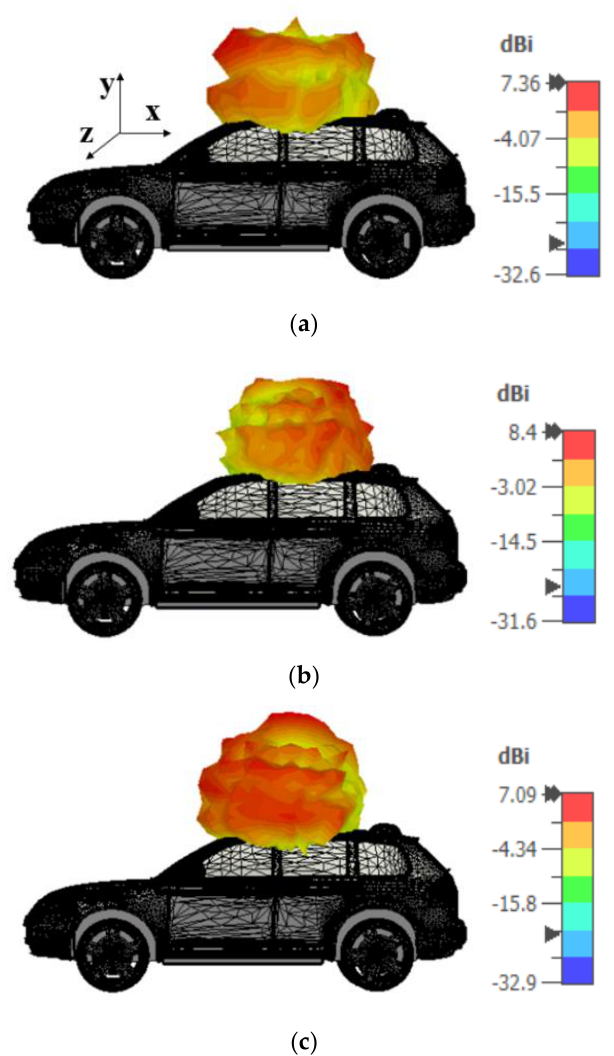
Figure 21. On-car performance of the proposed antenna: ( a ) 1.5 GHz, ( b ) 2.45 GHz, ( c ) 5 GHz.